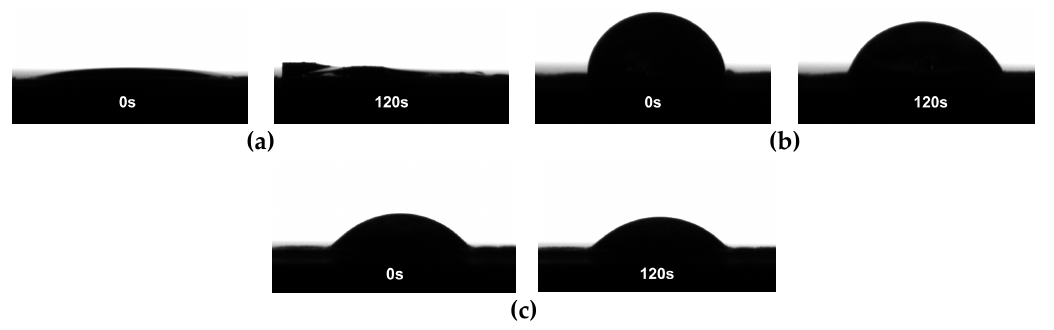
Figure 6. Contact angle measurements of: ( a ) CNFs films, ( b ) TMPES-modified CNFs films, and ( c ) TMPES and P4VP-PEO-modified CNFs films.